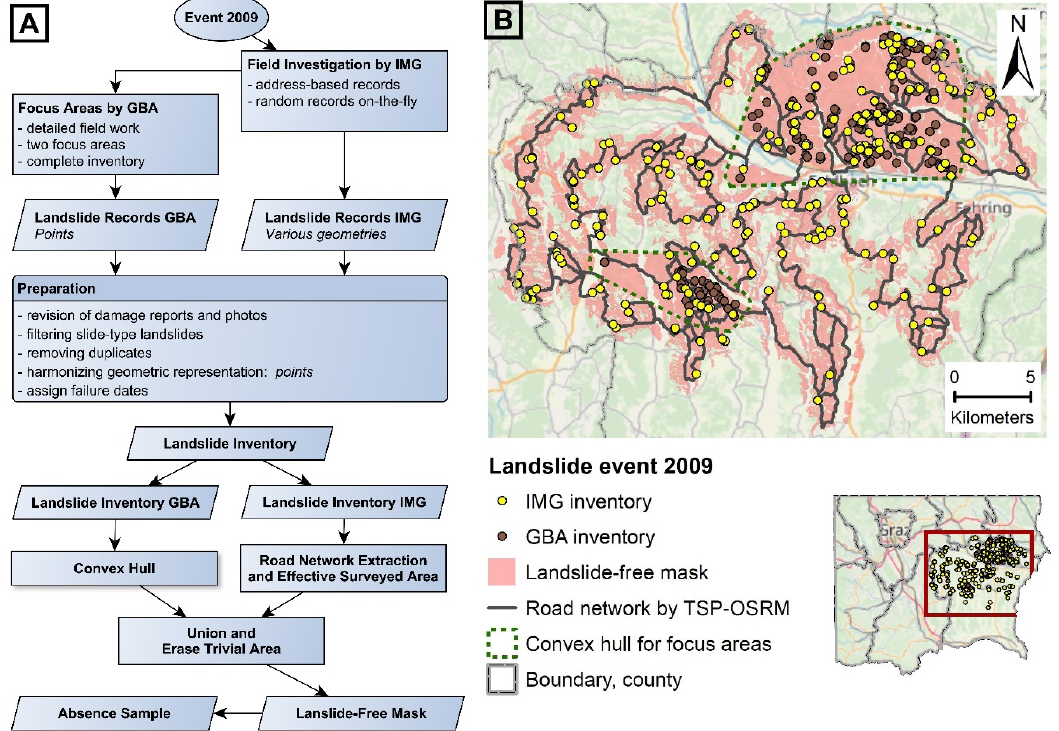
Figure 2. Overview of the sampling design for the 2009 rainfall-triggered landslide event: ( A ) Overview of the workflow; ( B ) Overview map with OSM data as background.